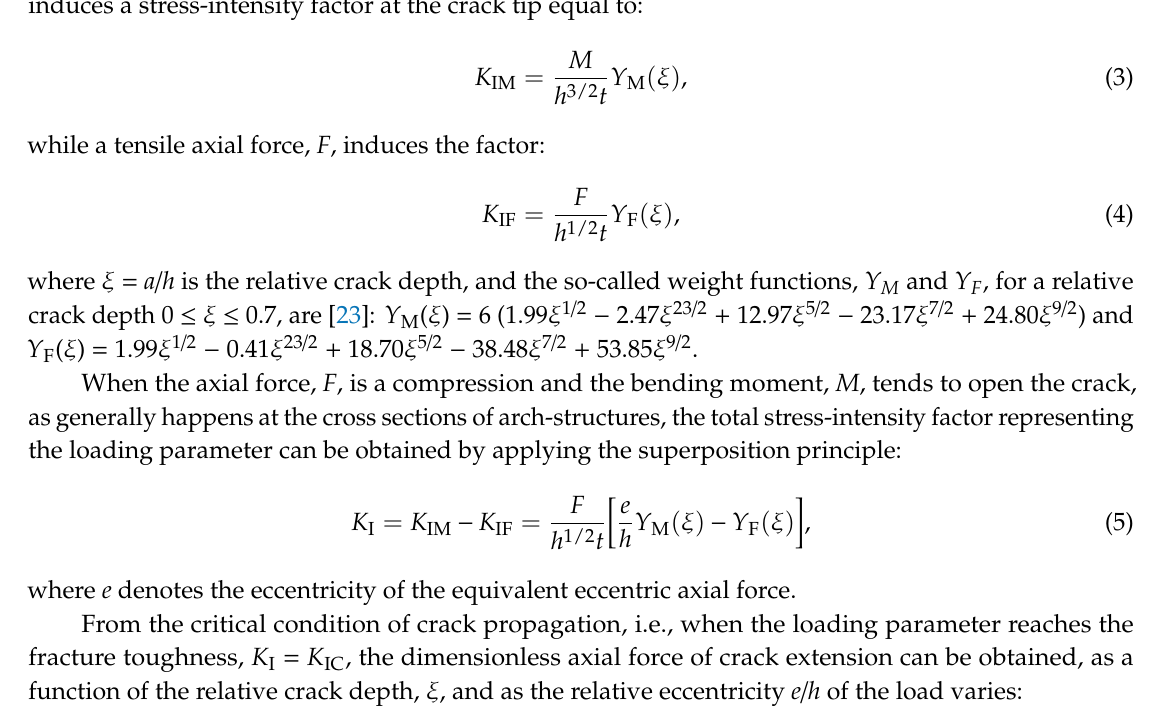
Figure 3. Arch segment subjected to off-center compression.